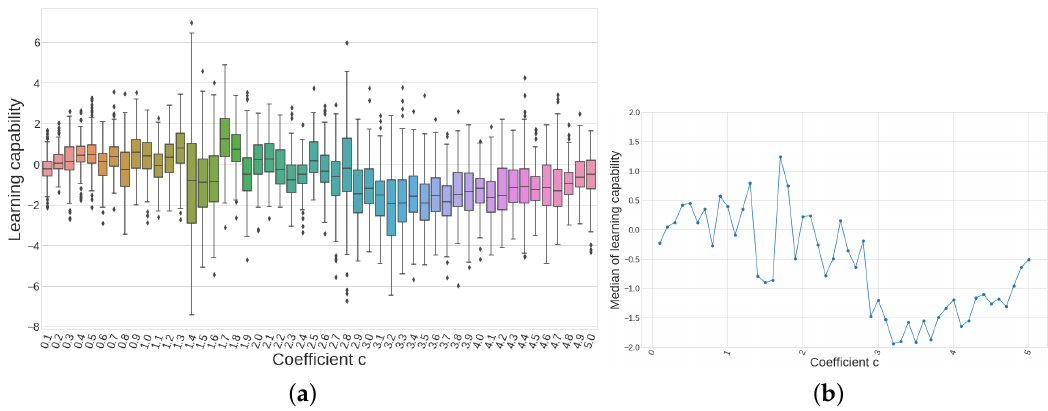
Figure 17. ( a ) Although the variance of each boxplot is different, the median appears to have certain tendency, being below 0 for c = 2.6 on; and ( b ) only coefficients below c = 2.6 are